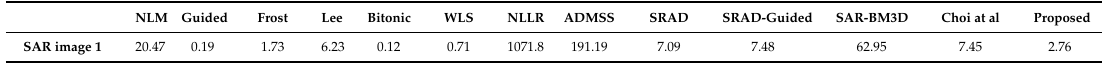
Table 13. Computational complexity results of the despeckling methods for the real SAR images 1 (512 × 512).